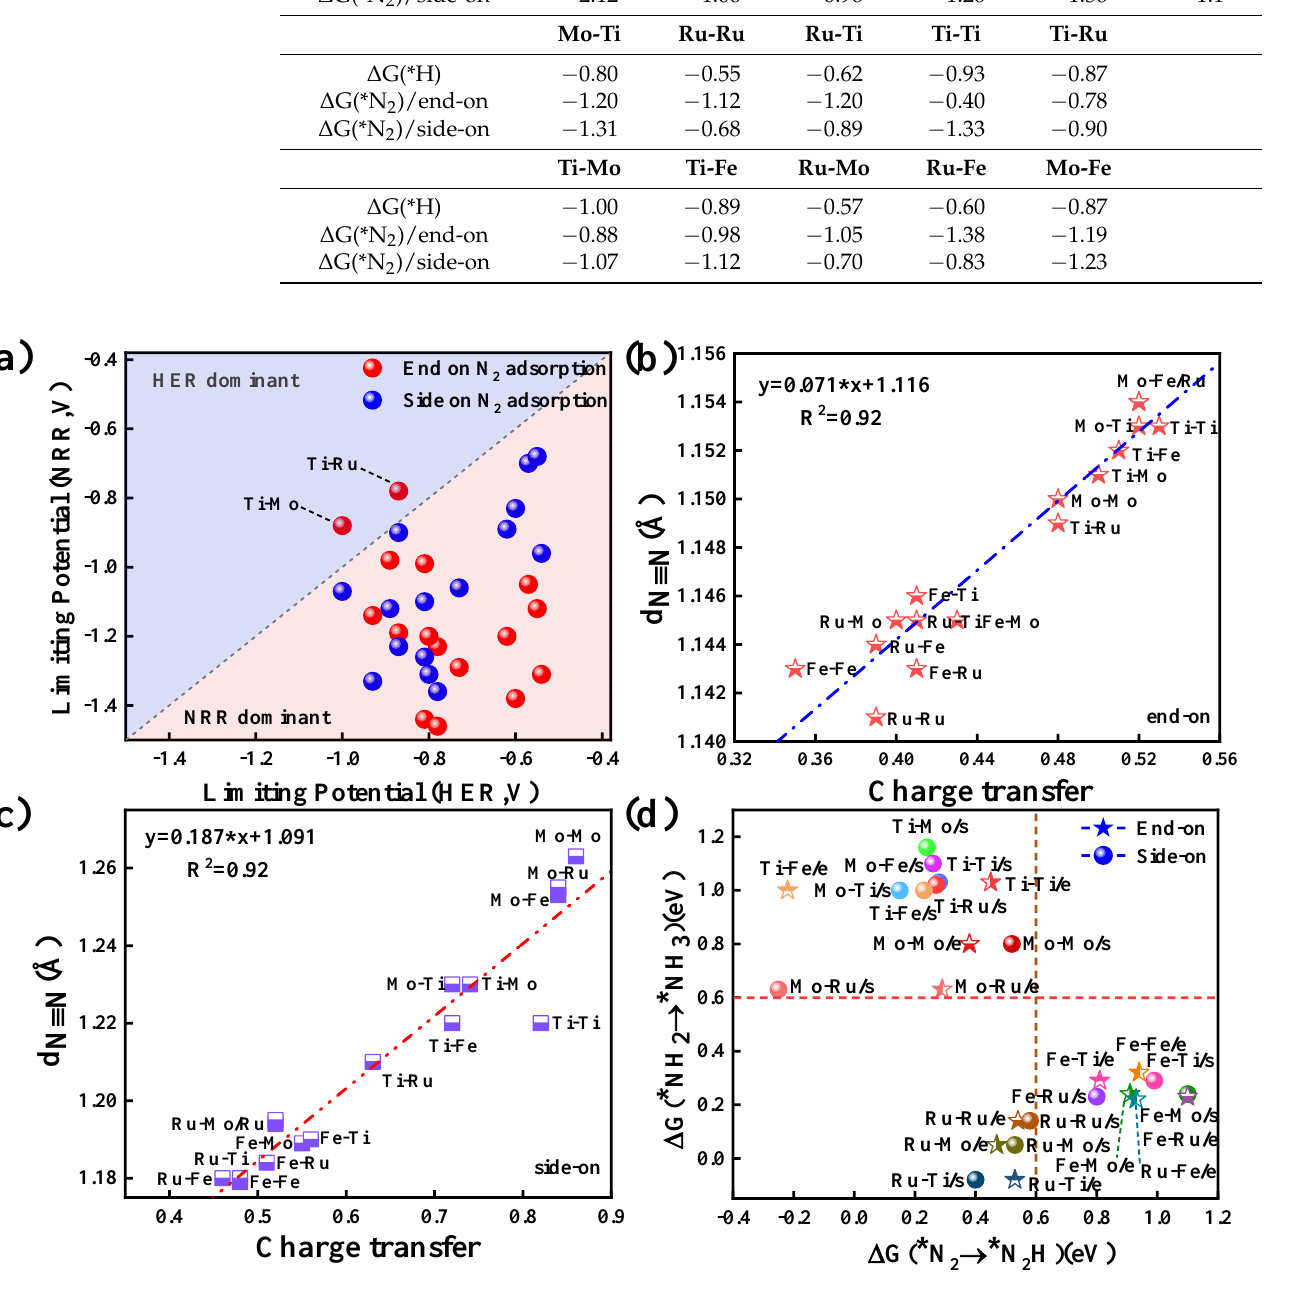
Figure 2. ( a ) Comparison of the HER limiting potentials and NRR limiting potentials via side-on and end-on mode. The relationship between the N-N bond length ( d N-N ) and the charge *N 2 gained from the TM 1 -TM 2 @V B -BN substrate through ( b ) end-on and ( c ) side-on pattern. ( d ) Free energy change of the first hydrogenation step (∆G *N2 → *N2H ) and the last hydrogenation step (∆G *NH2 → *NH3) for different DACs.